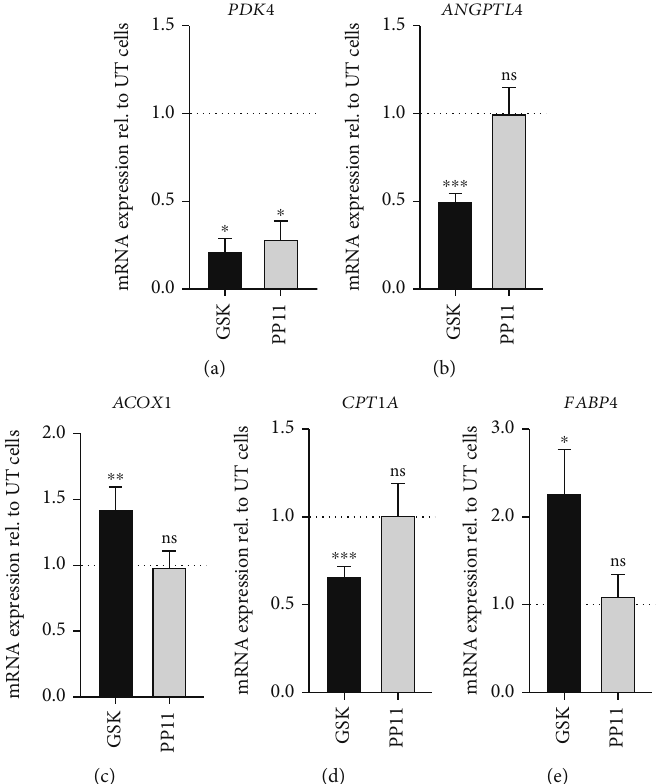
Figure 3: Expression pro fi le of PPAR β / δ , PPAR α , and PPAR γ target genes in hAD-MSC inactivated for PPAR β / δ . (a, b) Comparison of the expression levels of PPAR β / δ target genes ( PDK4 and ANGPTL4 ) between untreated (UT) hAD-MSC (dashed line), GSK3787-pretreated hAD-MSC (GSK), and PP11-pretreated hAD-MSC (PP11). PDK4 (a) and ANGPTL4 (b) expressions were normalized to